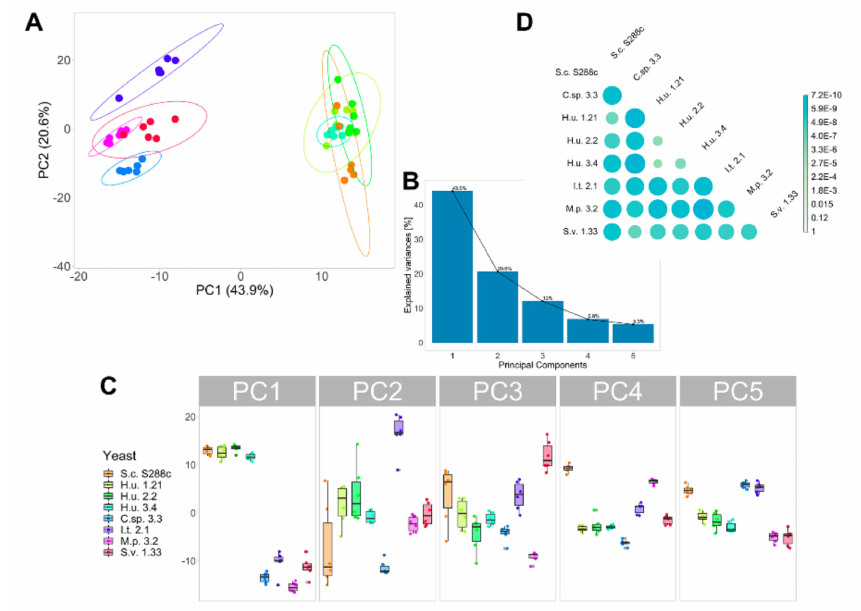
Figure 2. ( A ) Two-dimensional score plot generated using the first two principal components of the PCA. PCA was performed including all the 171 compounds annotated in six yeasts under investigation. ( B ) The scree plot shows the variance explained by the first five principal components. ( C ) Box plots of the scores of each yeast under investigation for the first five principal components. ( D ) The result of the pairwise MANOVA tests between yeast species based on the first five principal components of the PCA is reported as a heat map indicating significant di ff erences in the yeast lipid